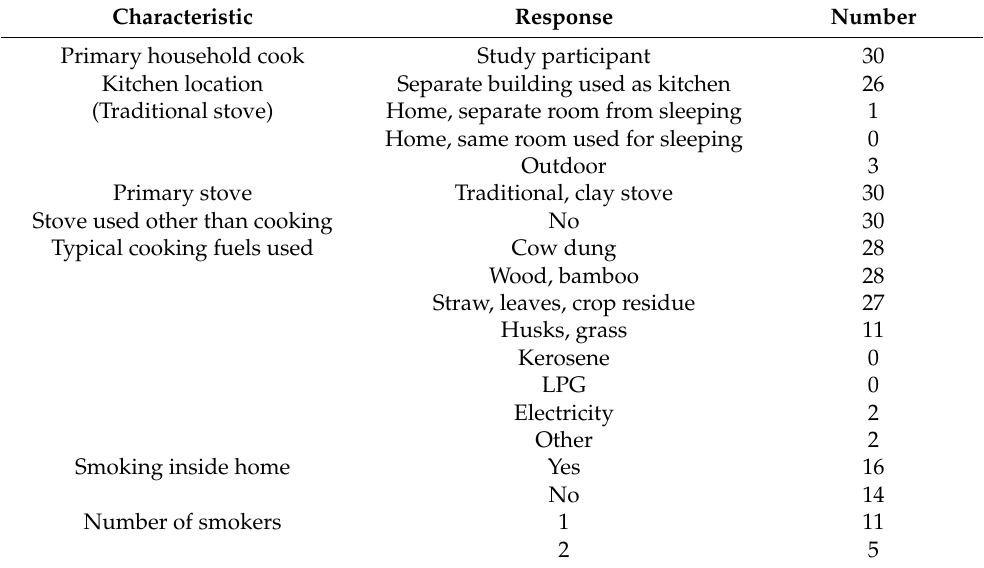
Table 1. Cooking, fuel, and tobacco use